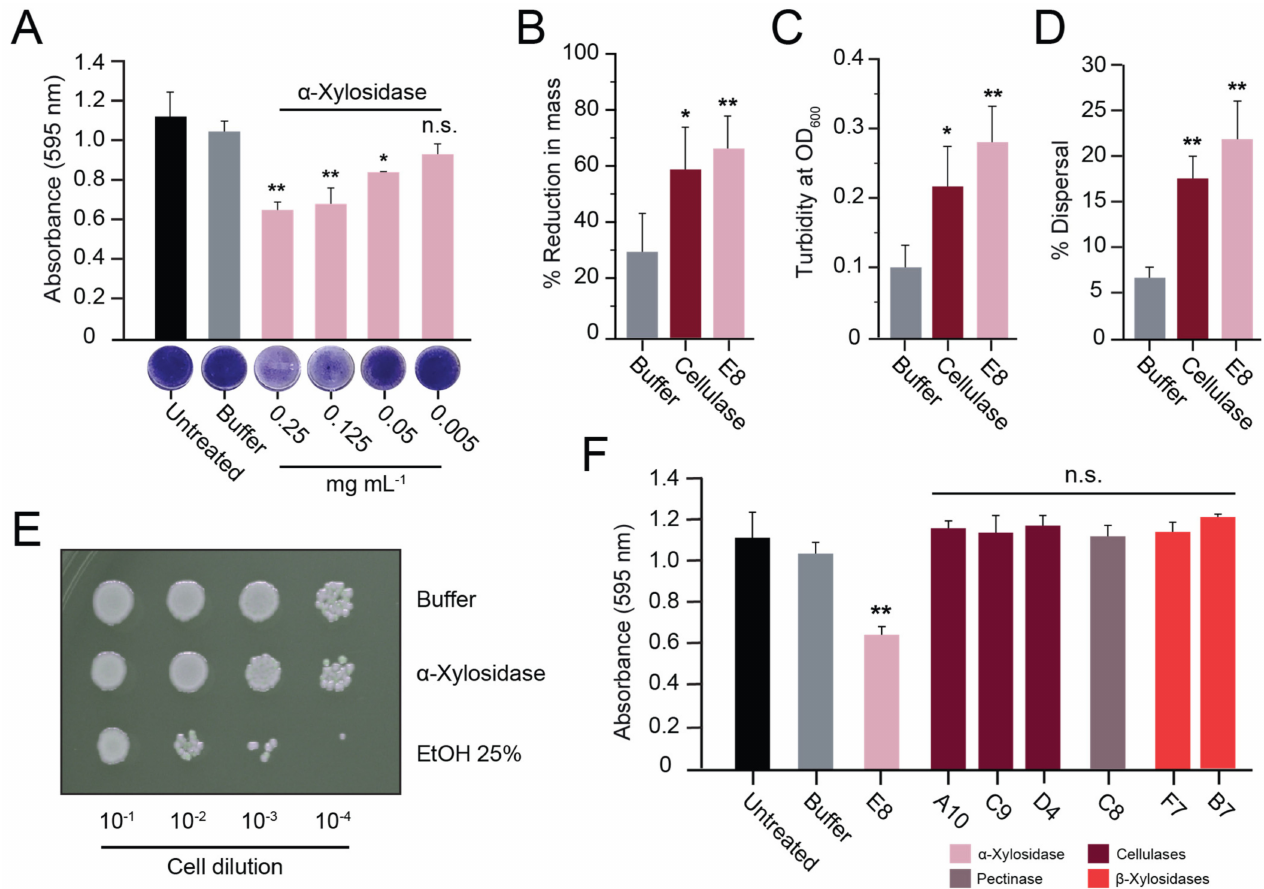
Figure 4. Purified α -xylosidase disperses S. aureus biofilms. ( A ) S. aureus biofilms grown on polystyrene were treated with purified α -xylosidase and stained with crystal violet. In the